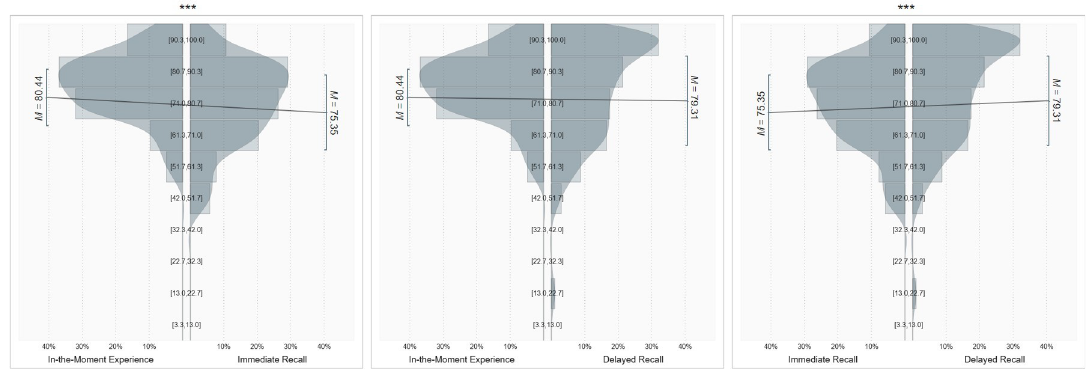
Fig 2. Distribution of eating happiness experienced in-the-moment (across 8 days) and at immediate (immediately after EMA) and delayed (after 4 weeks) recall. Note . Smoothed density distributions show the type of distribution and histograms depict the relative frequency of each response category, while means and standard deviations are depicted as lines above the distribution. For comparison, mean values are connected via a line; ��� indicates p � .001.